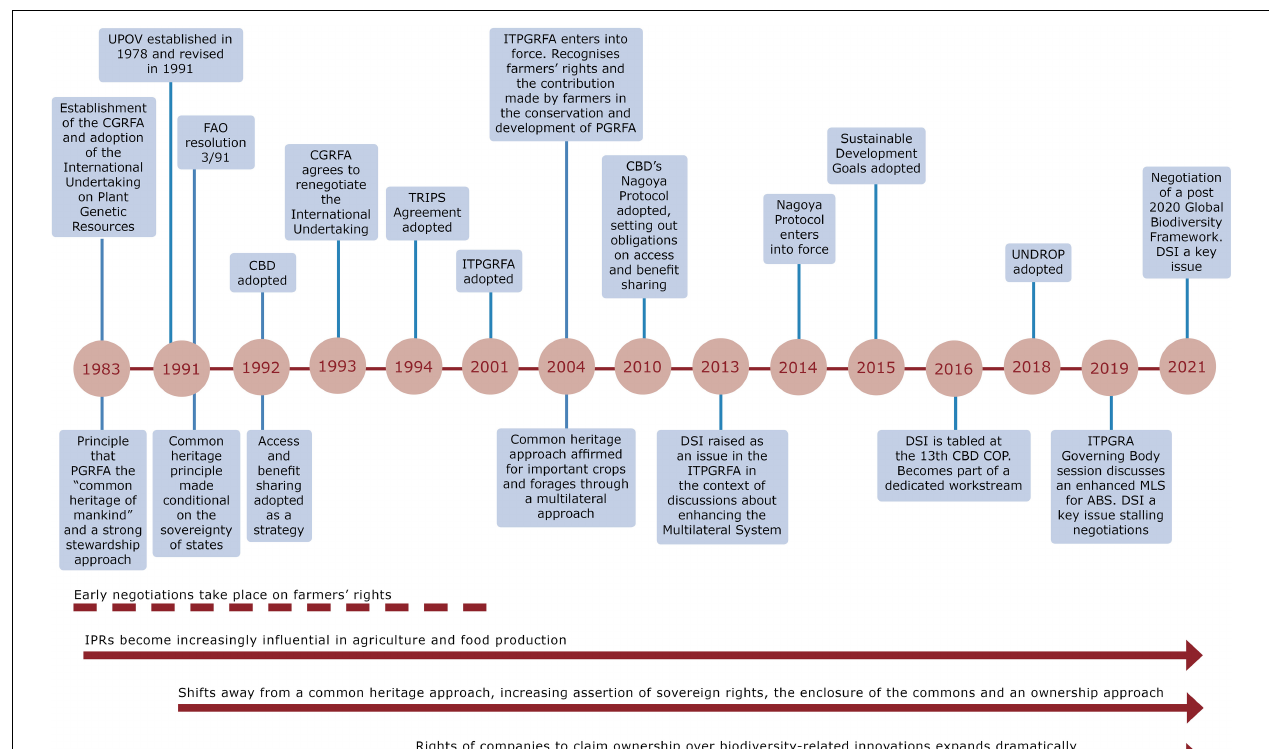
FIGURE 1 | A timeline of key international agreements and trends shaping the ownership and use of